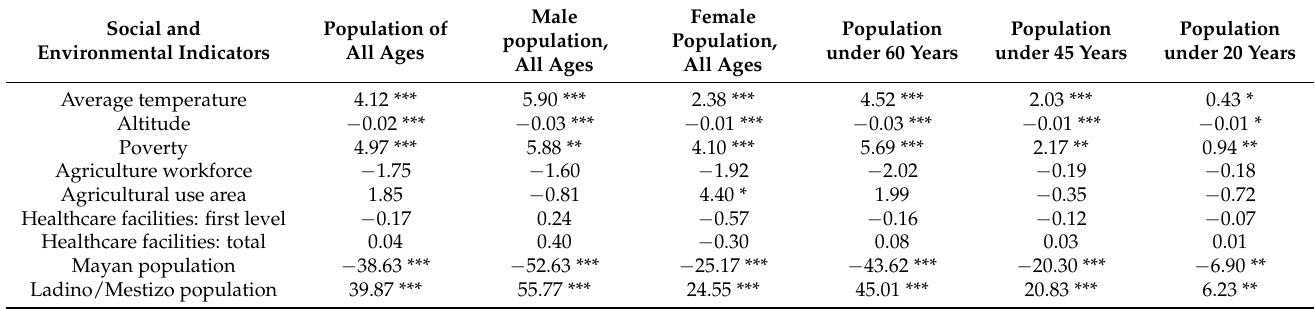
Table 5. Bivariate linear regression coefficients for other relevant social and environmental indicators and municipal mortality rates for chronic kidney disease, Guatemala 2009–2019 ( N =